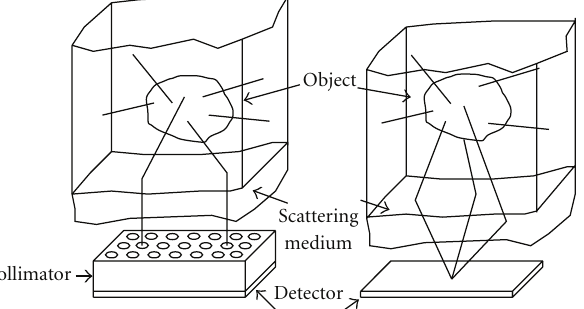
Figure 10: Two imaging modalities using Compton-scattered radiation with and without collimation (reprinted with permission from